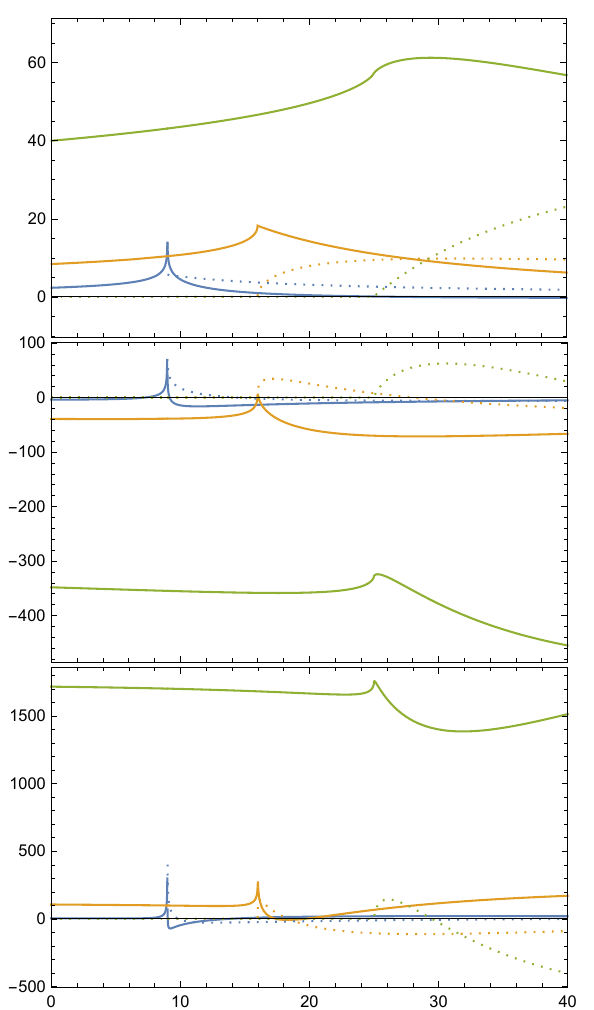
for l = 2 , 3 , 4 (blue, orange, green) and n = 0 , 1 , 2 (upper, Figure 3 . The banana integrals J ( n ) l, 1 middle and lower panels). On the x -axis we have drawn the variable t = p 2 /m 2 = 1 /z . The solid lines correspond to the real part, whereas the dashed lines represent the imaginary